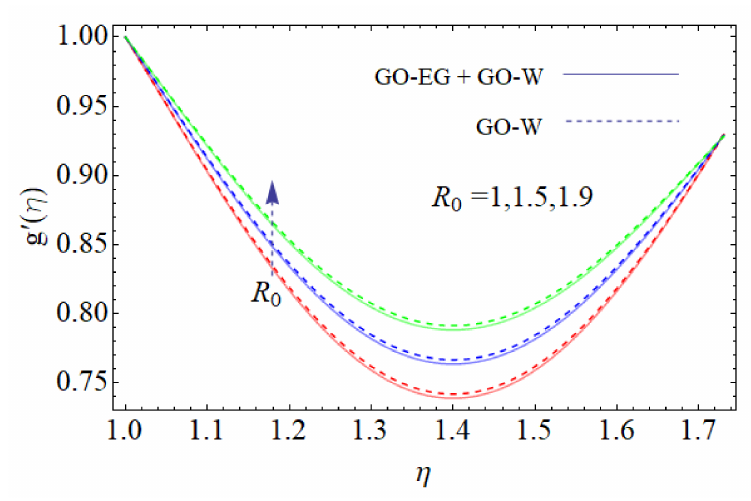
Figure 10. Influence of the rotation parameter on the velocity profile.